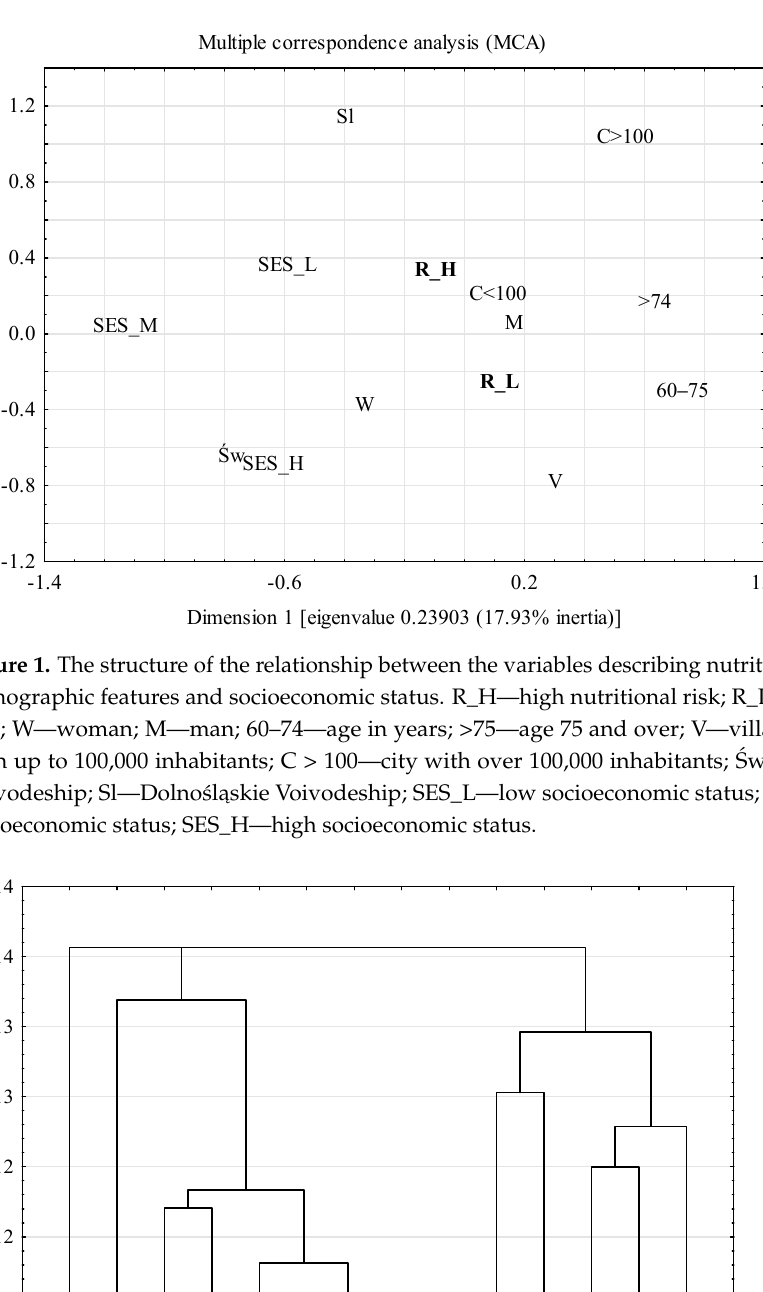
Table 2. Occurrence of nutritional risk depending on selected demographic characteristics and so- cioeconomic status.